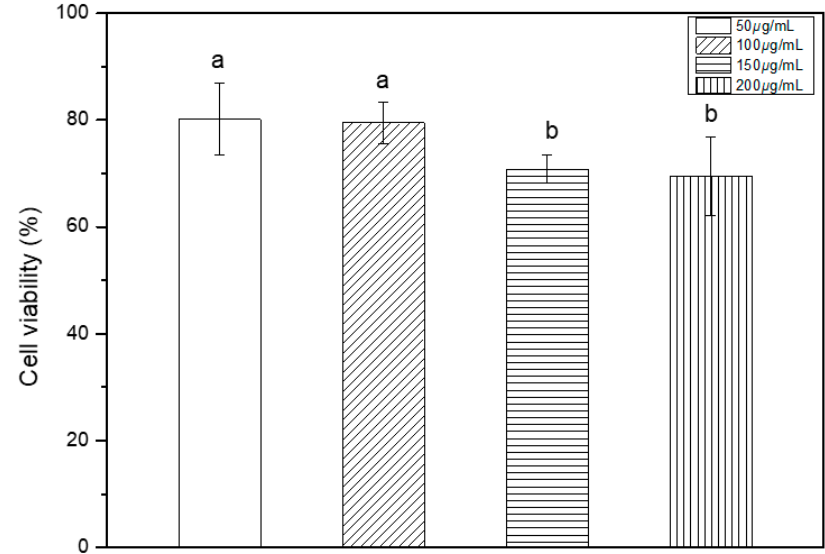
Figure 1. Paeonia lactiflora extract of cell viability (contents of 50 µ g/mL, 100 µ g/mL, 150 µ g/mL, and 200 µ g/mL.). ab The difference letter indicates statistics significant difference by One-Way ANOVA ( p <